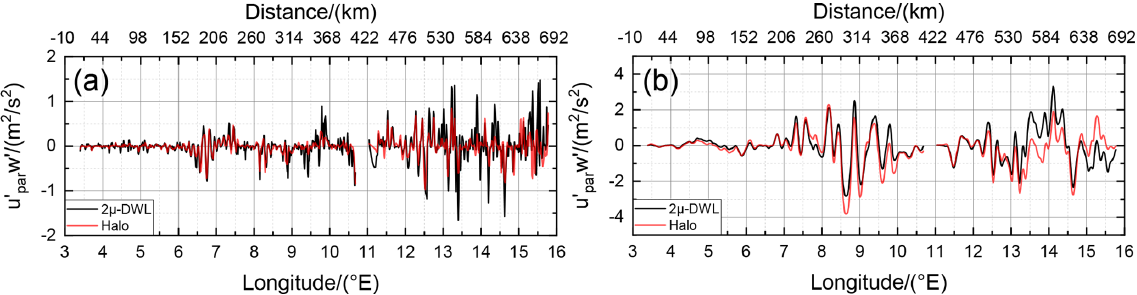
Figure 10. u (cid:48) par w (cid:48) measured by the 2µmDWL (black) and HALO (red) at 7 . 8km for the short-wave class (a) and the long-wave class (b) ,